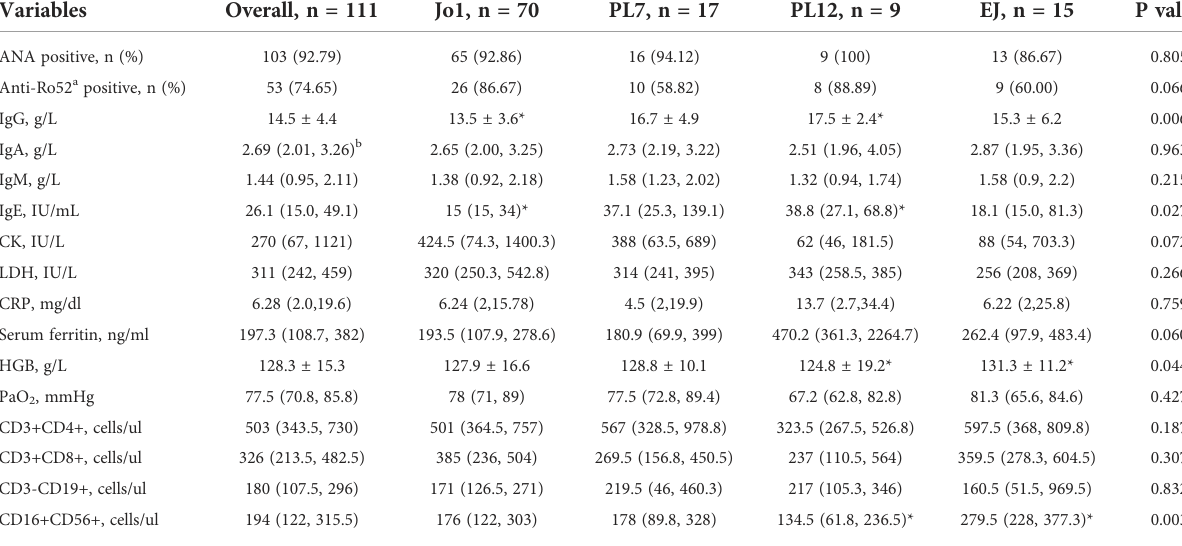
TABLE 2 Comparison of serological features of patients with ASS-ILD.